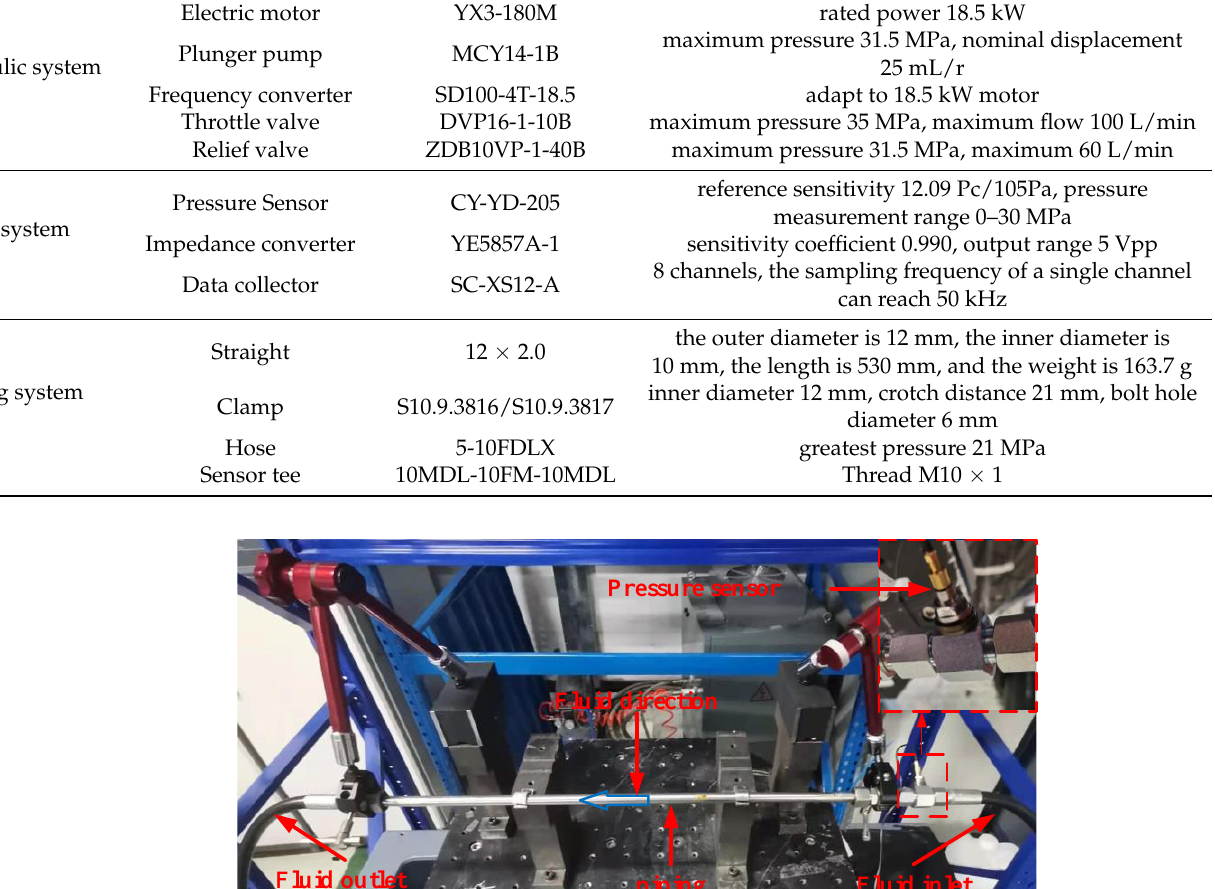
Figure 12. Load pressure ( p 1 = 4.375 MPa) waveform. ( a ) Time domain diagram; ( b ) frequency domain map.